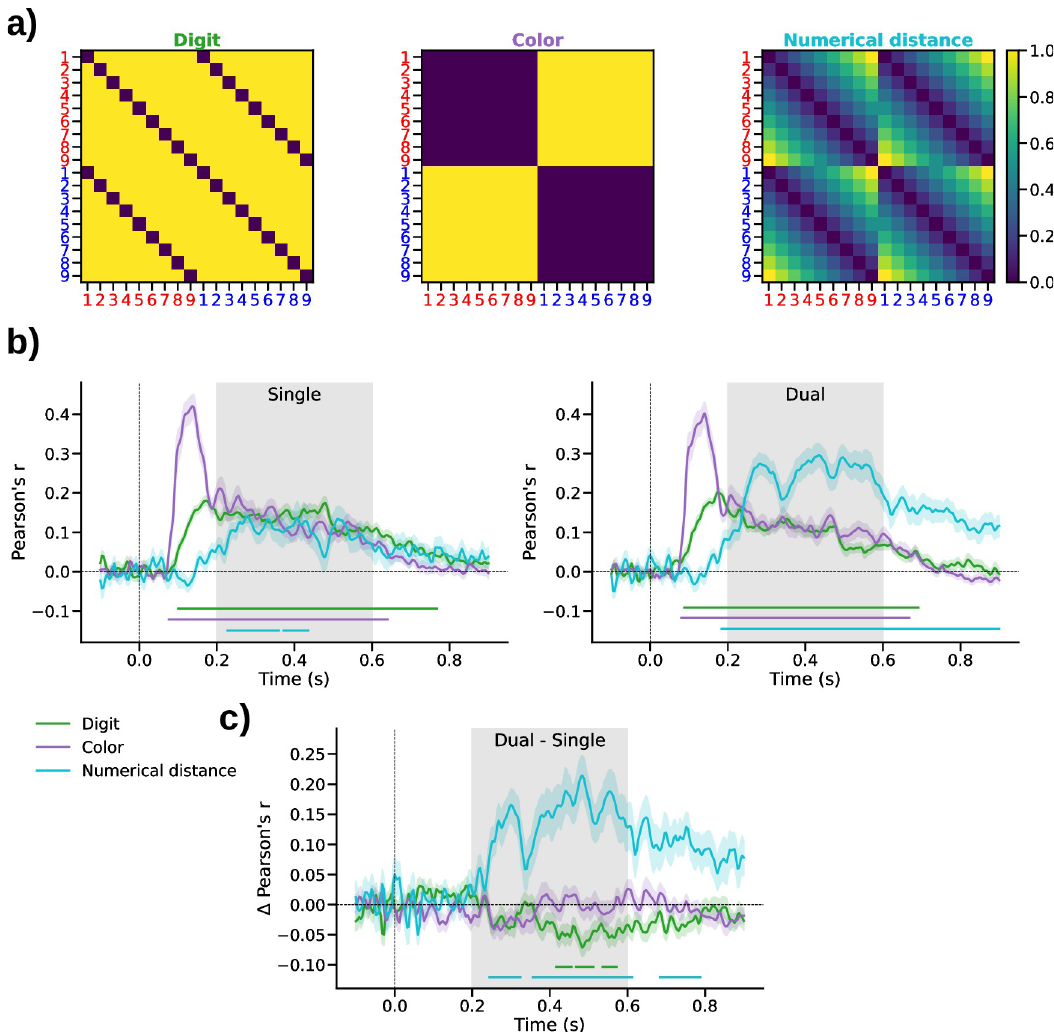
Fig 2. RSA results. a) Model RDMs encoding individual sample attributes. Left , “Digit” model encoding the unique number symbols; Middle , “Color” model encoding whether a sample was red or blue; Right , “Numerical distance” model encoding the samples’ magnitude (1–9). For visual clarity, the model RDMs are illustrated before orthogonalization (see Materials and methods ). b) Correlation between orthogonalized model RDMs and the empirical ERP-RDMs in the single-stream (left) and dual-stream (right) task. Colored shadings show SE. Marker lines on bottom indicate significant differences from zero (p cluster < 0.005). Gray shading outlines the time window used in subsequent neurometric analysis (see Fig 3 below). c) Difference in correlation between the single- and dual-stream tasks. Same conventions as in b